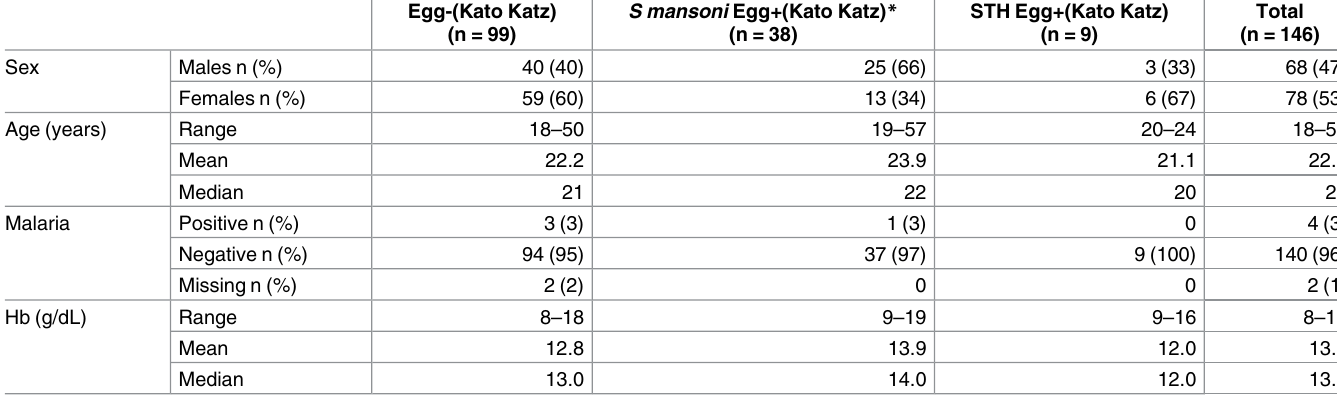
Table 1. Baseline characteristics of 146 participants who met all study requirements, completed at least baseline and first follow-up, as well as receivedtetanus boost and a minimum 2 of 3 hepatitis B